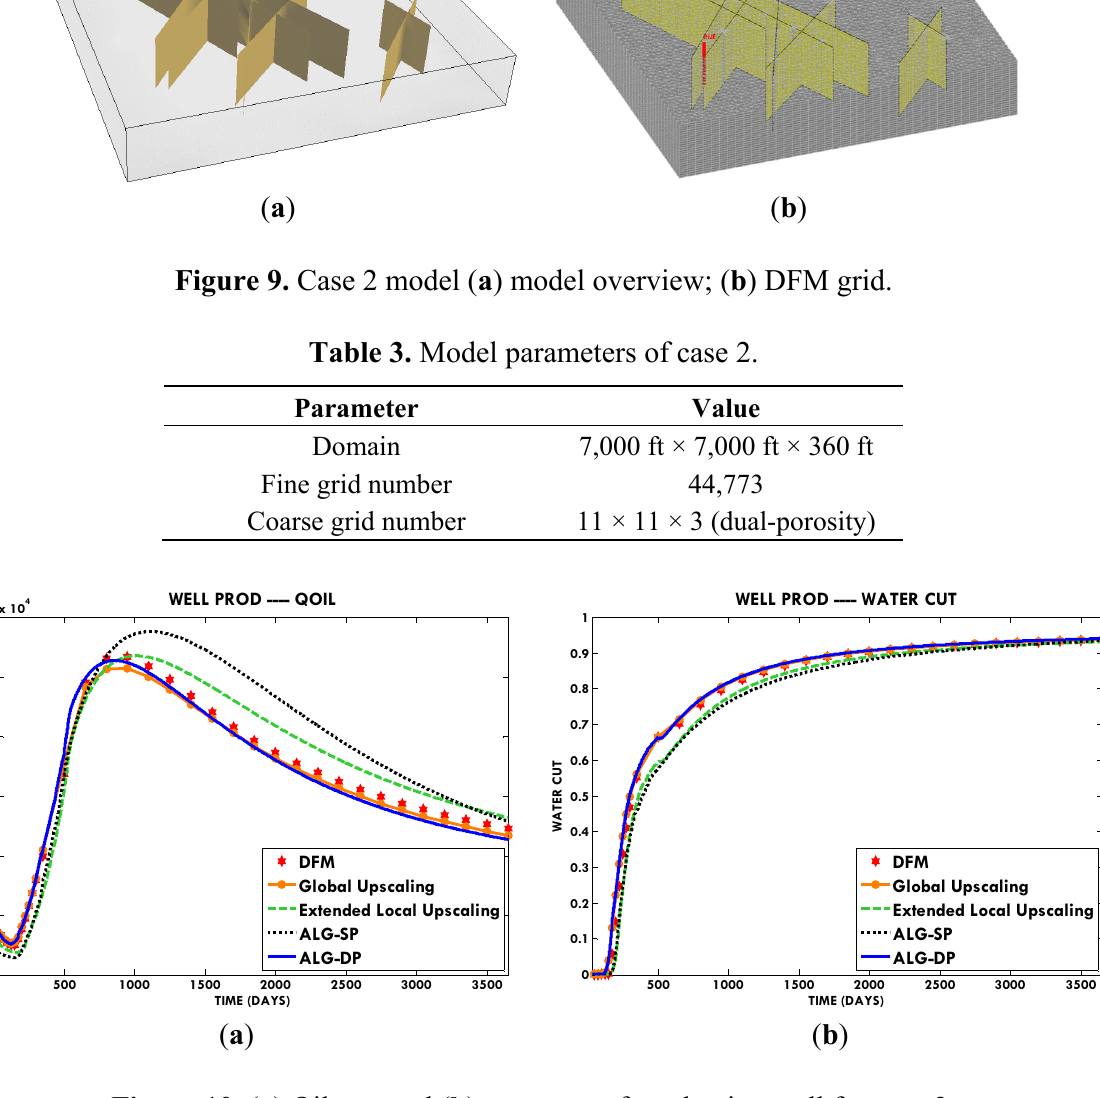
Figure 10. ( a ) Oil rate and ( b ) water cut of production well for case